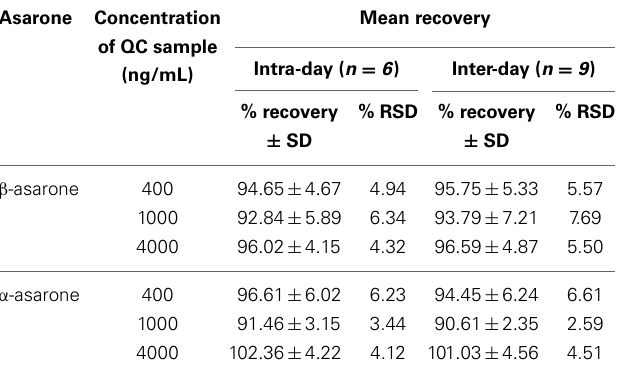
Table 3 | Screening and quantification of β -asarone and α asarone in herbal products for children by